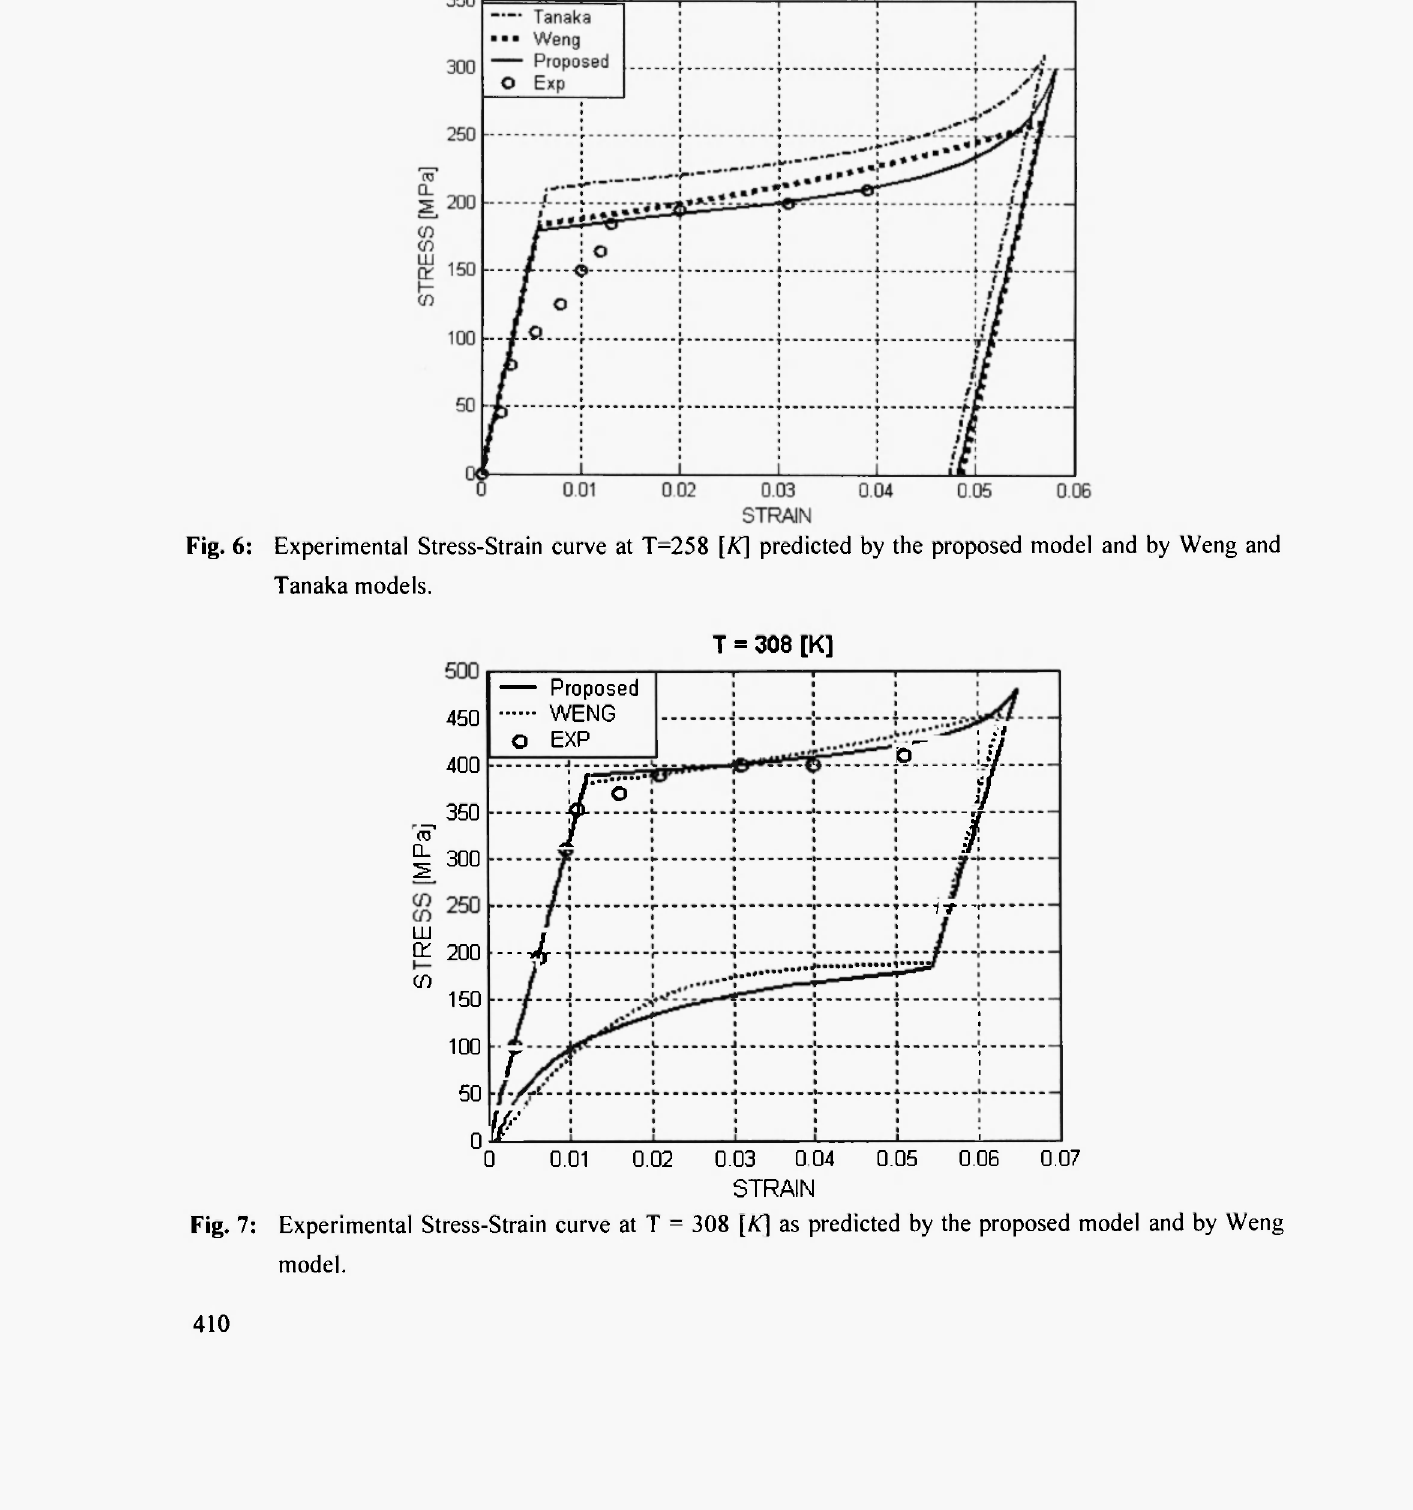
Experimental Stress-Strain curve at T=258 [ΛΓ] predicted by the proposed model and by Weng and Tanaka models.